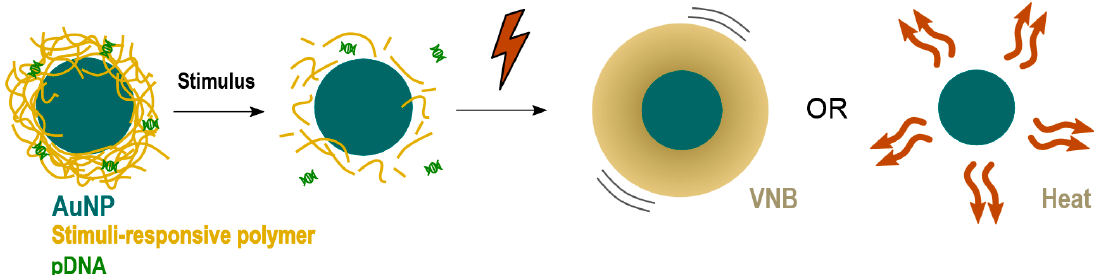
Figure 9. Alternative NP design for cytosolic delivery of intact pDNA after endocytosis.